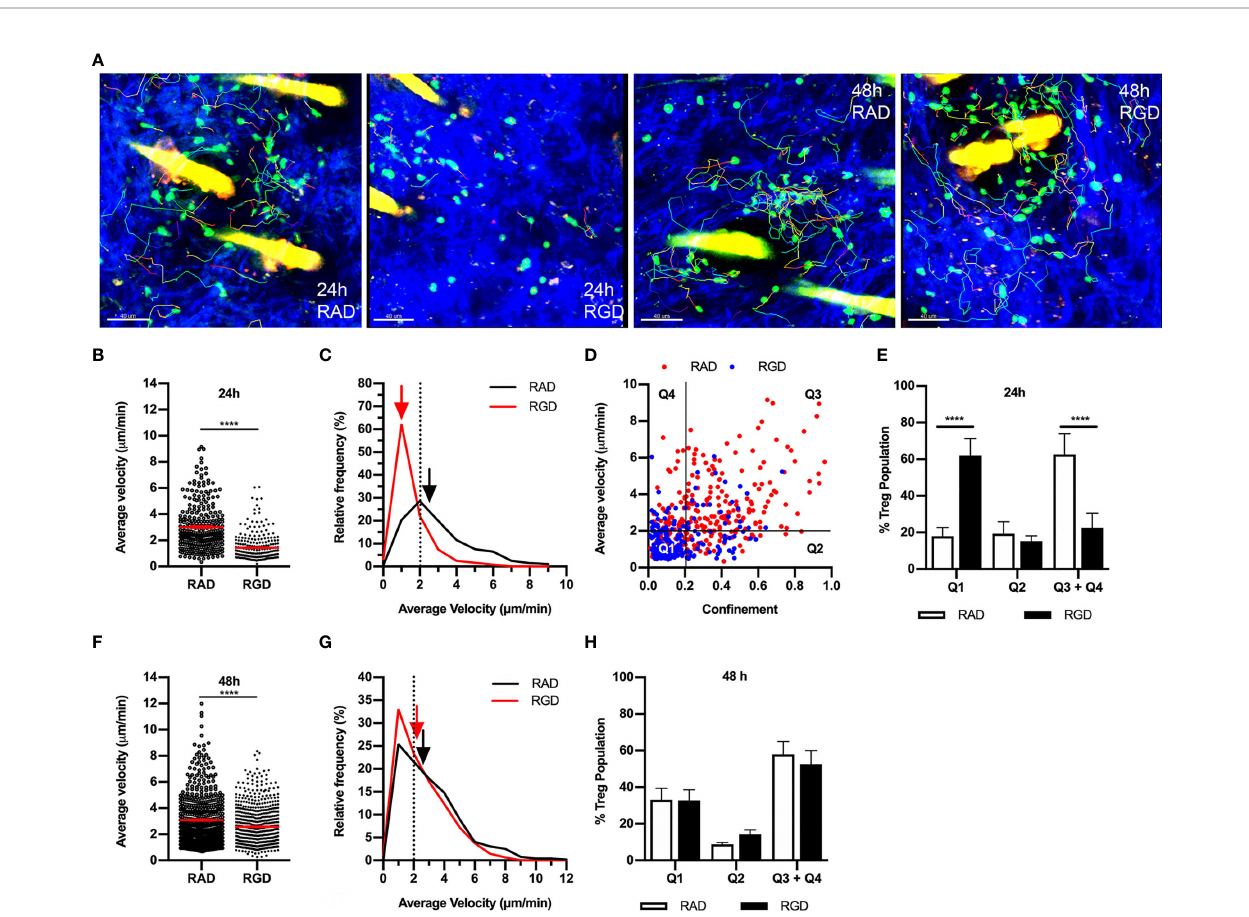
FIGURE 3 | RGD peptide-binding integrins modulate Treg migration during CS. The effect of RGD-binding integrins on Treg migration in CS-in fl amed skin was assessed using MP-IVM. Treg migration was examined following i.d. injection of RGD or RAD control peptides 2 h prior to visualization by MP-IVM. (A) MP-IVM images of Treg migration paths in RAD- and RGD-treated Foxp3-GFP mice 24 and 48 h post-CS induction. (B – H) Treg migration in mice treated with either RAD or RGD peptides 24 or 48 h after induction of CS. (B, F) Average velocity of Treg migration 24 (B) and 48 h (F) after induction of CS. Data show velocities for individual Tregs as well as group mean ± sem. (C, G) Relative frequency distributions of the average velocities of individual Tregs from RAD- or RGD-treated mice 24 (C) and 48 h (G) post CS induction. Arrows indicate the median velocity, and the dotted line indicates the 2 µm/min motility threshold. (D) Dot plot distribution of individual Tregs from RAD (red) and RGD (blue)-treated mice at the 24 h CS timepoint, plotted according to average velocity and con fi nement. (E, H) Distributions of Tregs within the four quadrants plotted for the (E) 24 h and (H) 48 h CS timepoints. Data represent the mean ± SEM of > 250 cells derived from 3-5 mice/group. Quadrant data represent mean ± SEM of data averaged from 3 fi elds of view (fov)/mouse. Velocity data in (B, F) were compared using Mann-Whitney tests. Quadrant data in (E, H) were assessed using a multiple comparison t test using the Holm-Sidak method ( a , 0.05). **** p < 0.0001 for the comparisons